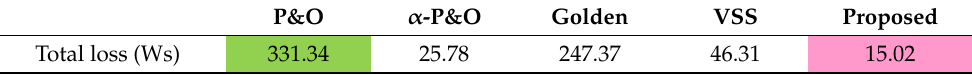
Figure 10. Tracking waveforms of the proposed method under EN50530 test condition. Table 5. Simulated results of five compared MPPT methods under varying irradiation